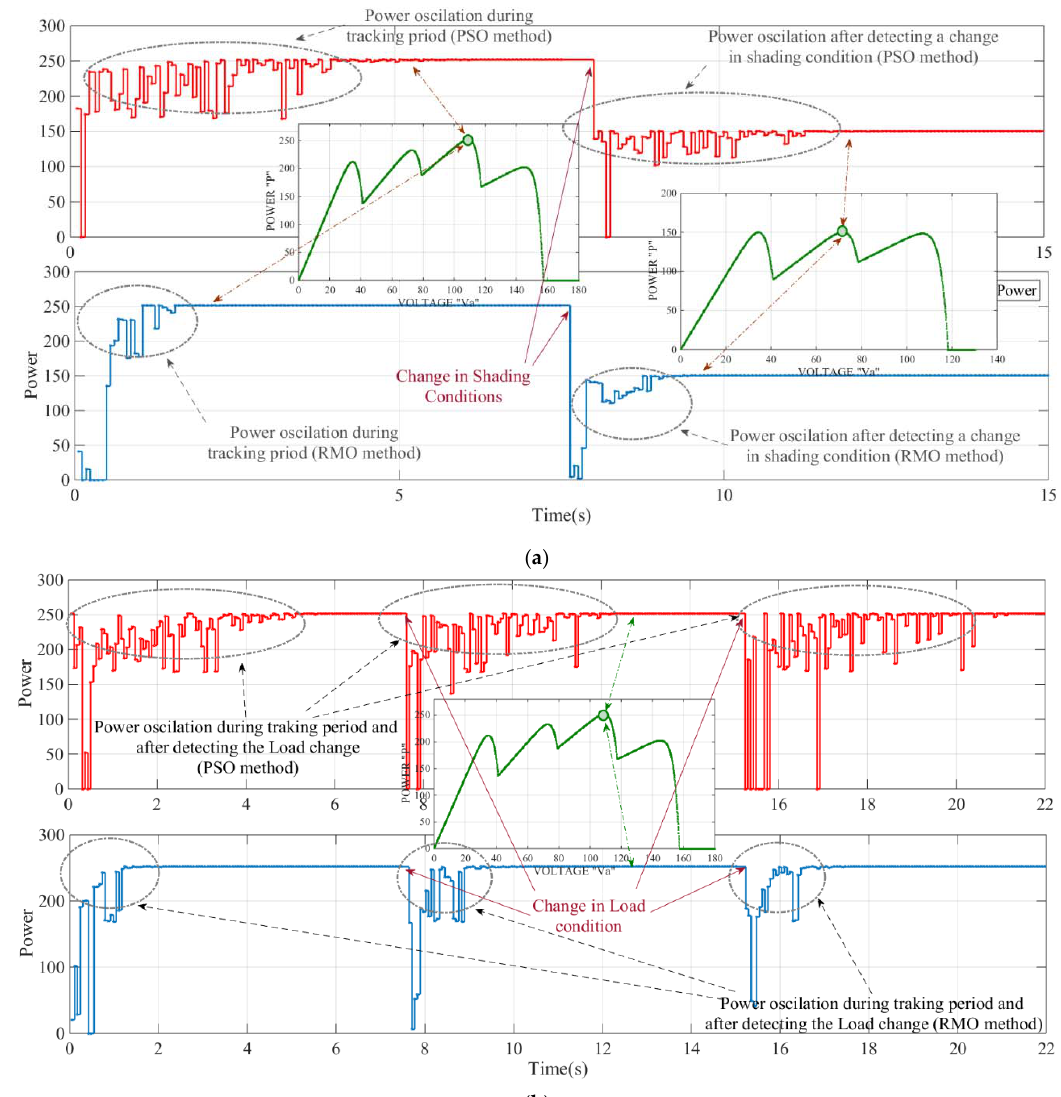
Figure 15. Dynamic performance of proposed method vs. PSO: ( a ) during shading condition changes; ( b ) during load changes.